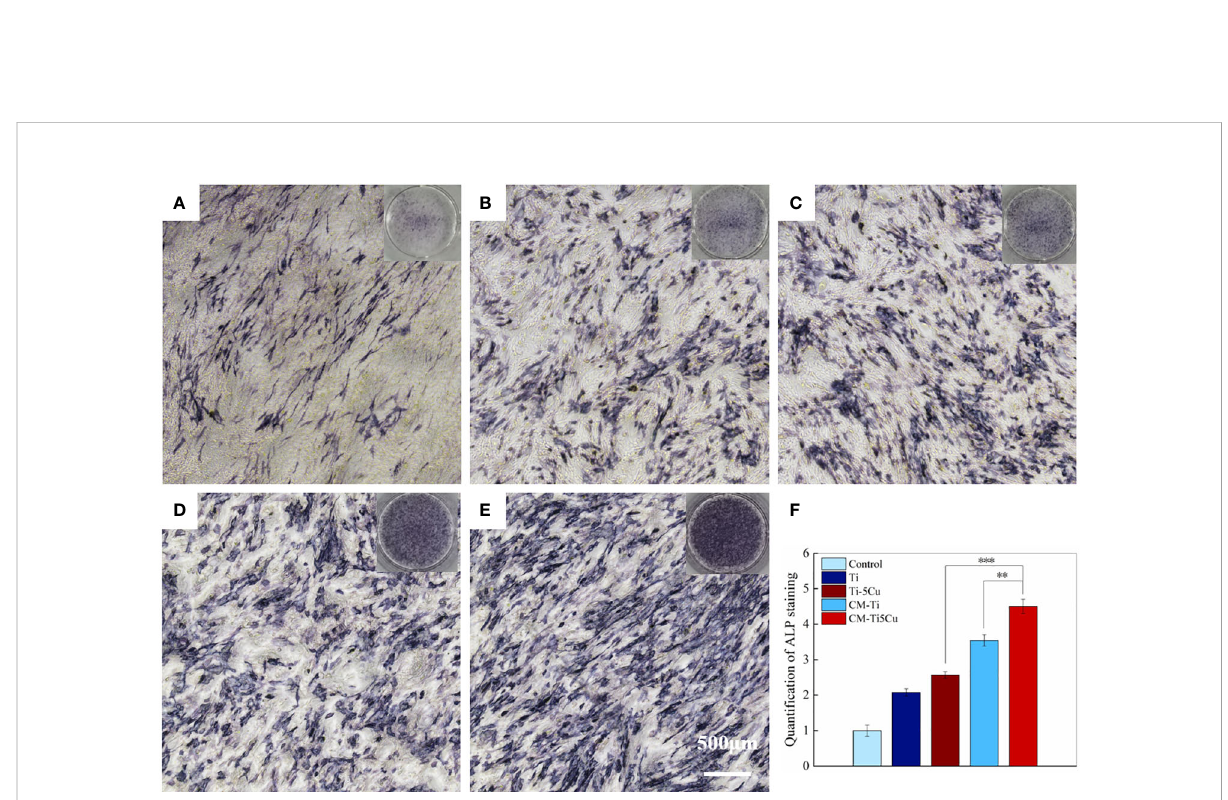
FIGURE 9 The ALP staining of MC3T3-E1 cells after cultured with conditioned medium and material extracts for 7 days. (A) Control group; (B) Ti extract group; (C) Ti-5Cu extract group; (D) CM-Ti group; (E) CM-Ti5Cu group; (F) quanti fi cation statistical analysis of ALP staining (n = 3; **p < 0.01 and ***p < 0.001).